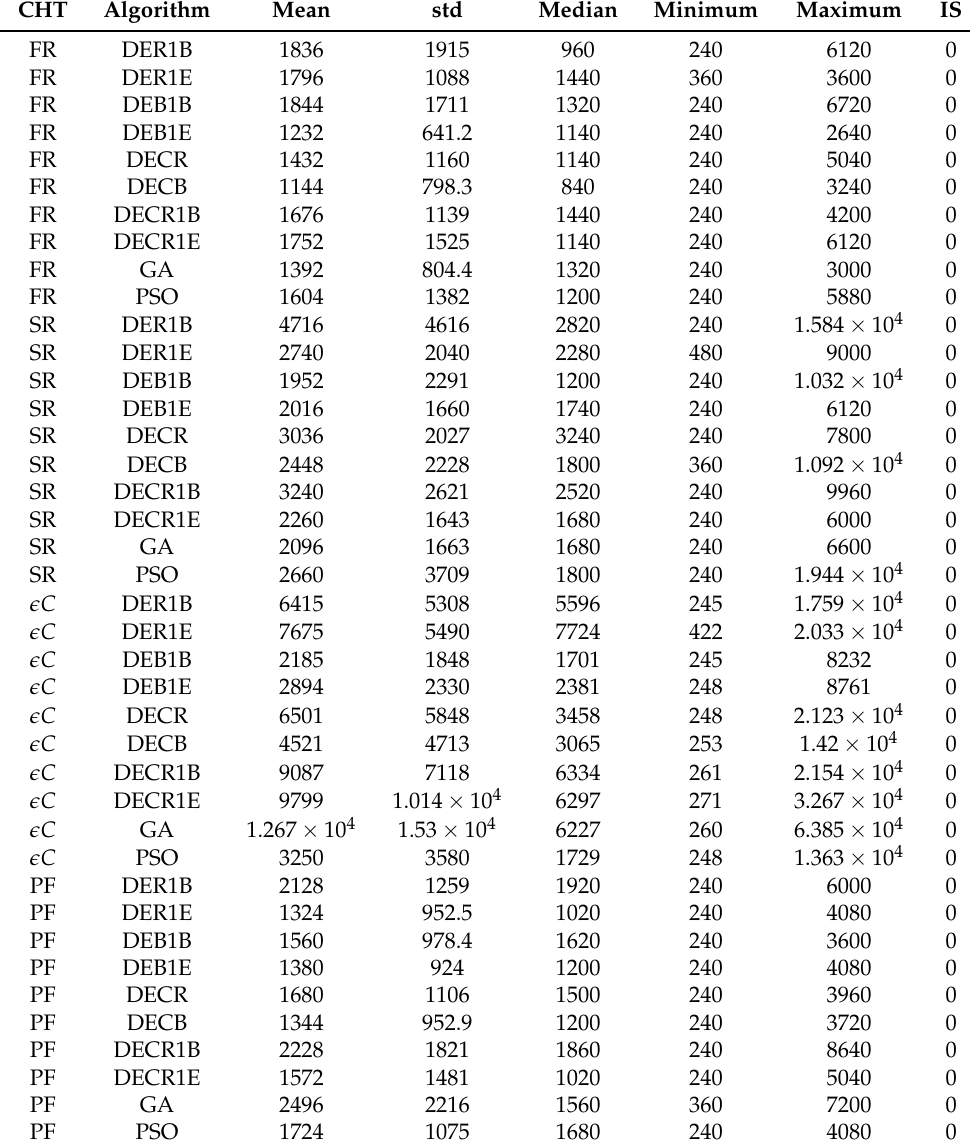
Table A17. EVALS descriptive statistics for study case 2: Cam-linkage mechanism. IS means the number of infeasible solutions through the